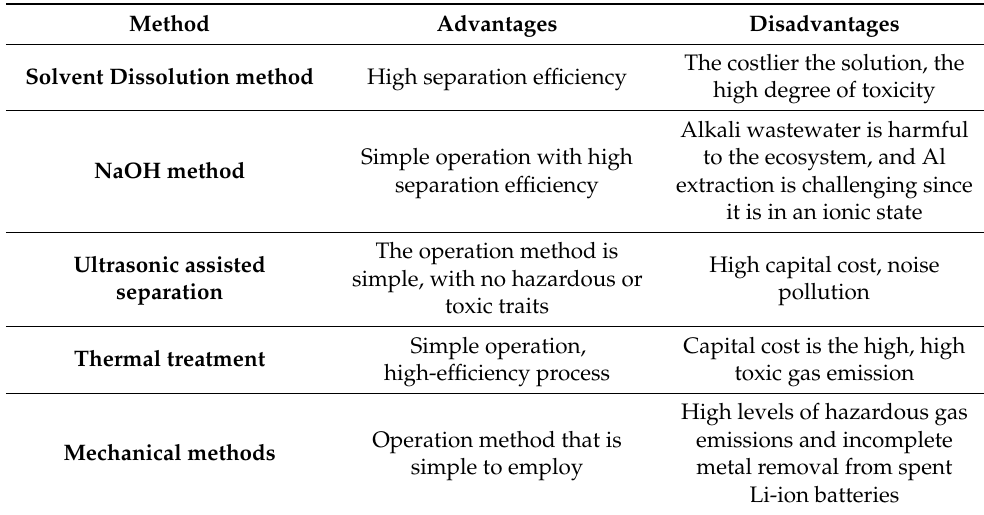
Table 2. Advantages and disadvantages of conventional pre-treatment methods (Data gathered from refs. [14,40]). Method Advantages Disadvantages High separation